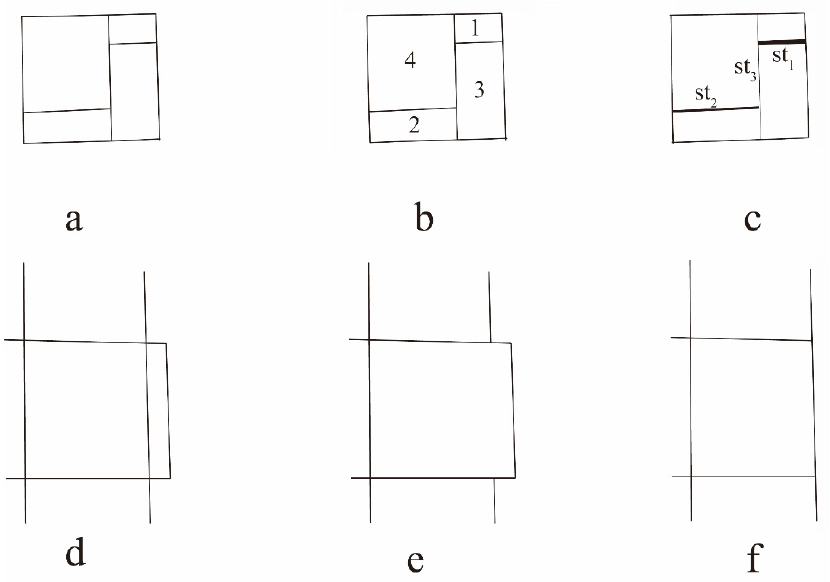
Figure 12 . A comparison of selection processes for the weighted Voronoi method and the mesh method; ( a ) a schematic road network with areal road segments; ( b ) selection results based on the mesh method for an areal road pattern; ( c ) selection results based on the weighted Voronoi diagram for an areal road pattern; ( d ) a schematic road network with hybrid road segments; ( e ) selection results based on the mesh method for a hybrid road pattern; ( f ) selection results based on the weighted Voronoi diagram method for a hybrid road pattern.